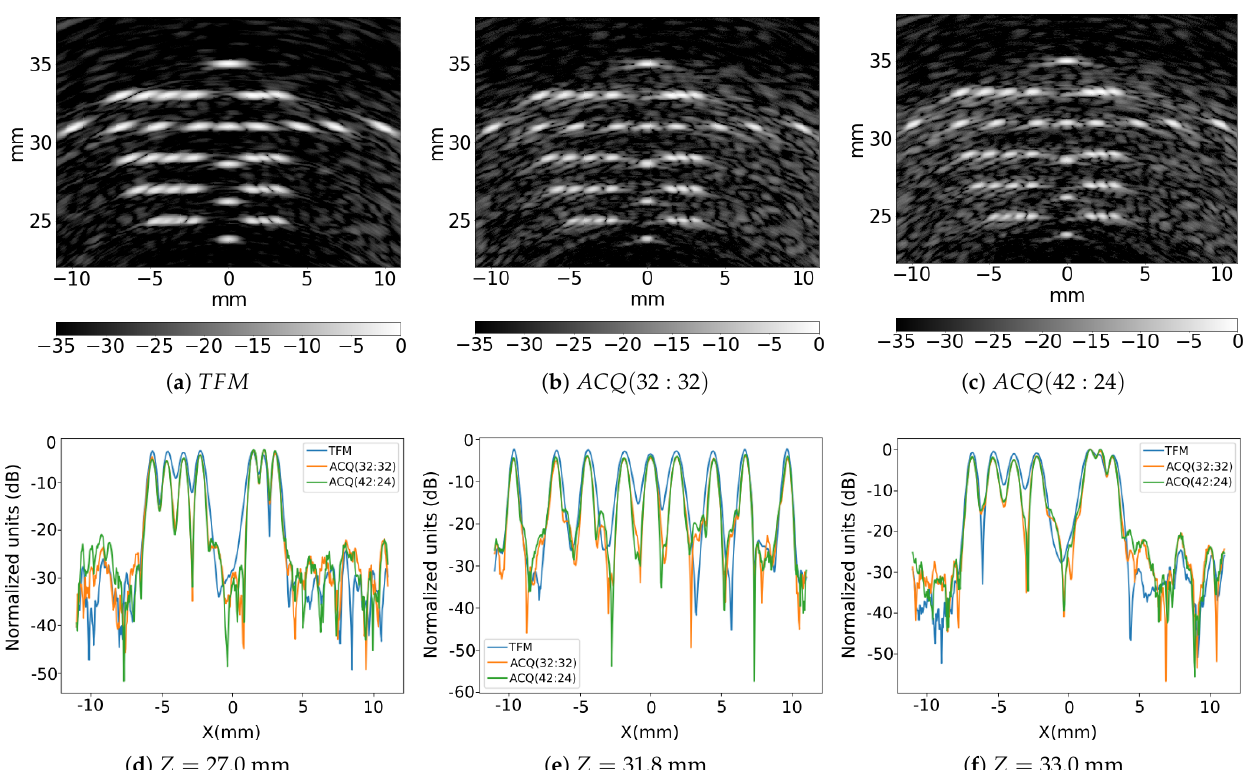
Figure 12. Images of simulated phantom to evaluate ultrasound medical imaging capabilities of the proposed acquisition strategies: ( a ) TFM ; ( b ) ACQ ( 32:32 ) and ( c ) ACQ ( 42:24 ) . ( d – f ): Lateral profiles obtained from the simulated images at different depths, for the three